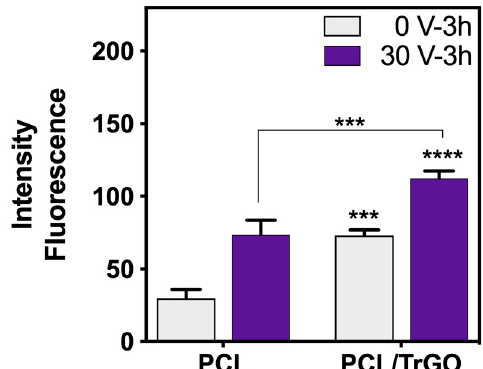
Figure 8. Metabolic activity graph of hBM-SCs obtained from the resazurin assay without ES (0 V) in gray and ES (30 V) in purple with 3 h of ES. *** and **** denote a significant difference with a value p < 0.001 and p < 0.0001, respectively, between the samples indicated, and a value p < 0.001 denotes the control sample PCL 0 V. n = 3 independent experiments were performed in triplicate per plate at three days from seeding cells in/on the scaffolds.